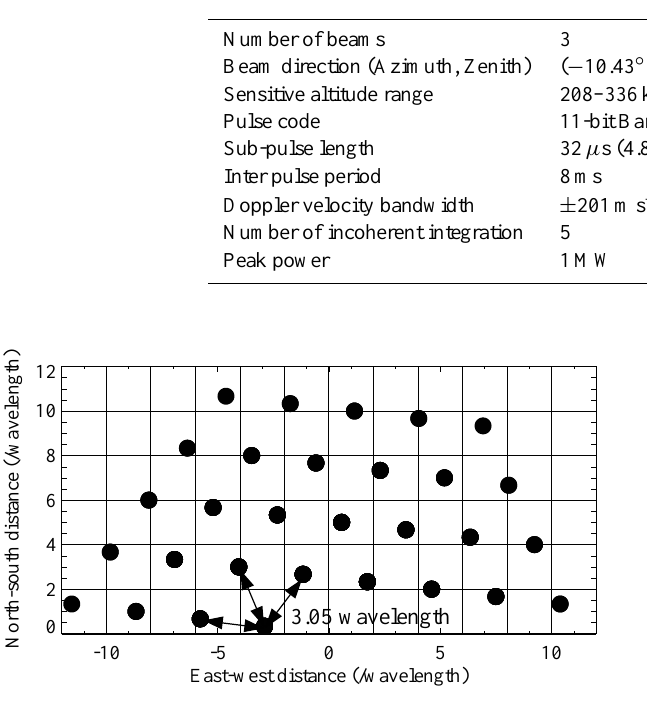
Fig. 3. Non-redundant baselines achieved by the 19 antenna sub- arrays and used for imaging analysis.